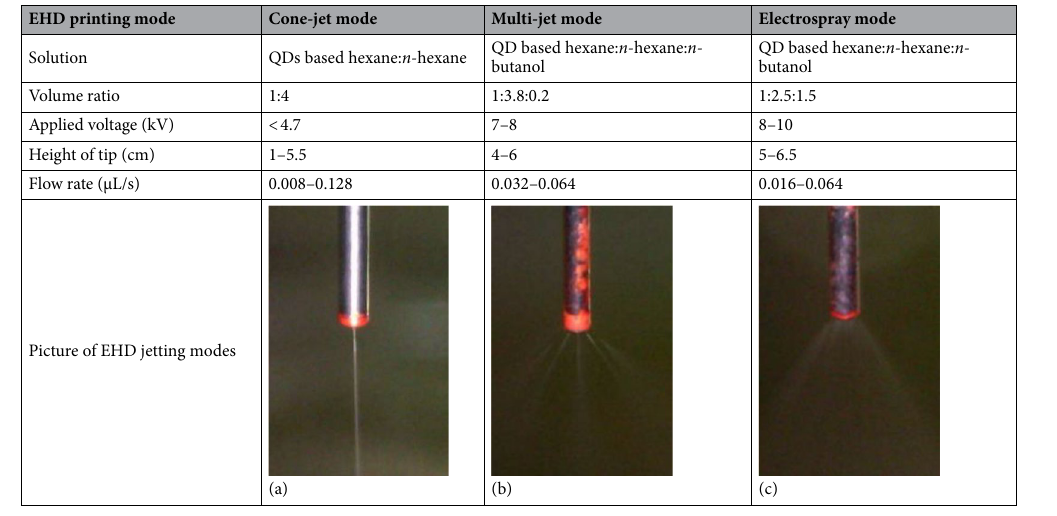
Table 1. Various EHD printing modes with solution formulations and processing